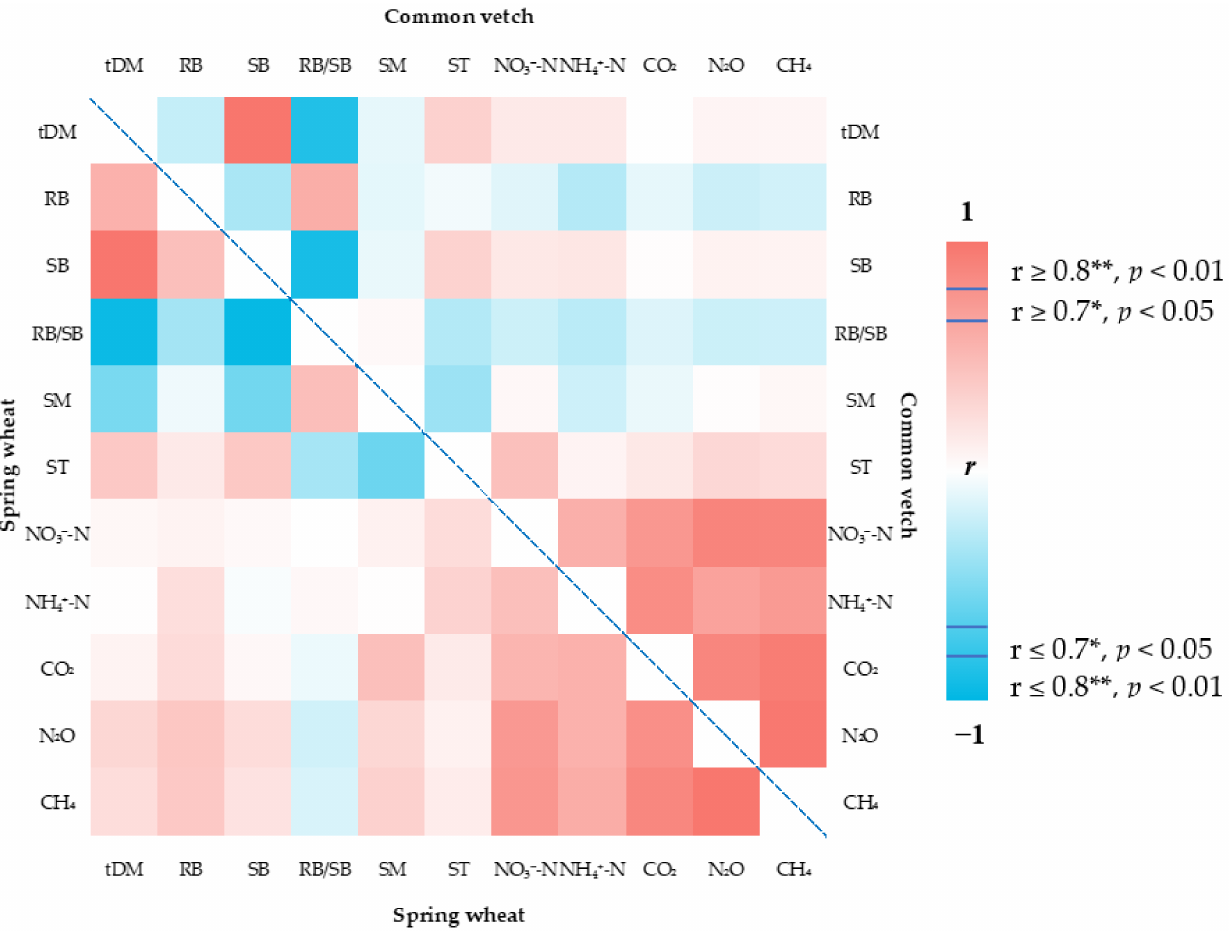
Figure 6. Matrix of Pearson correlation coefficients for common vetch and spring wheat. Red rectangles represent positive correlation coefficients and blue rectangles represent negative correlation coefficients. |r| ≥ 0.7* and p < 0.05 indicate significant correlation; |r| ≥ 0.8** and p < 0.01 indicate a very significant